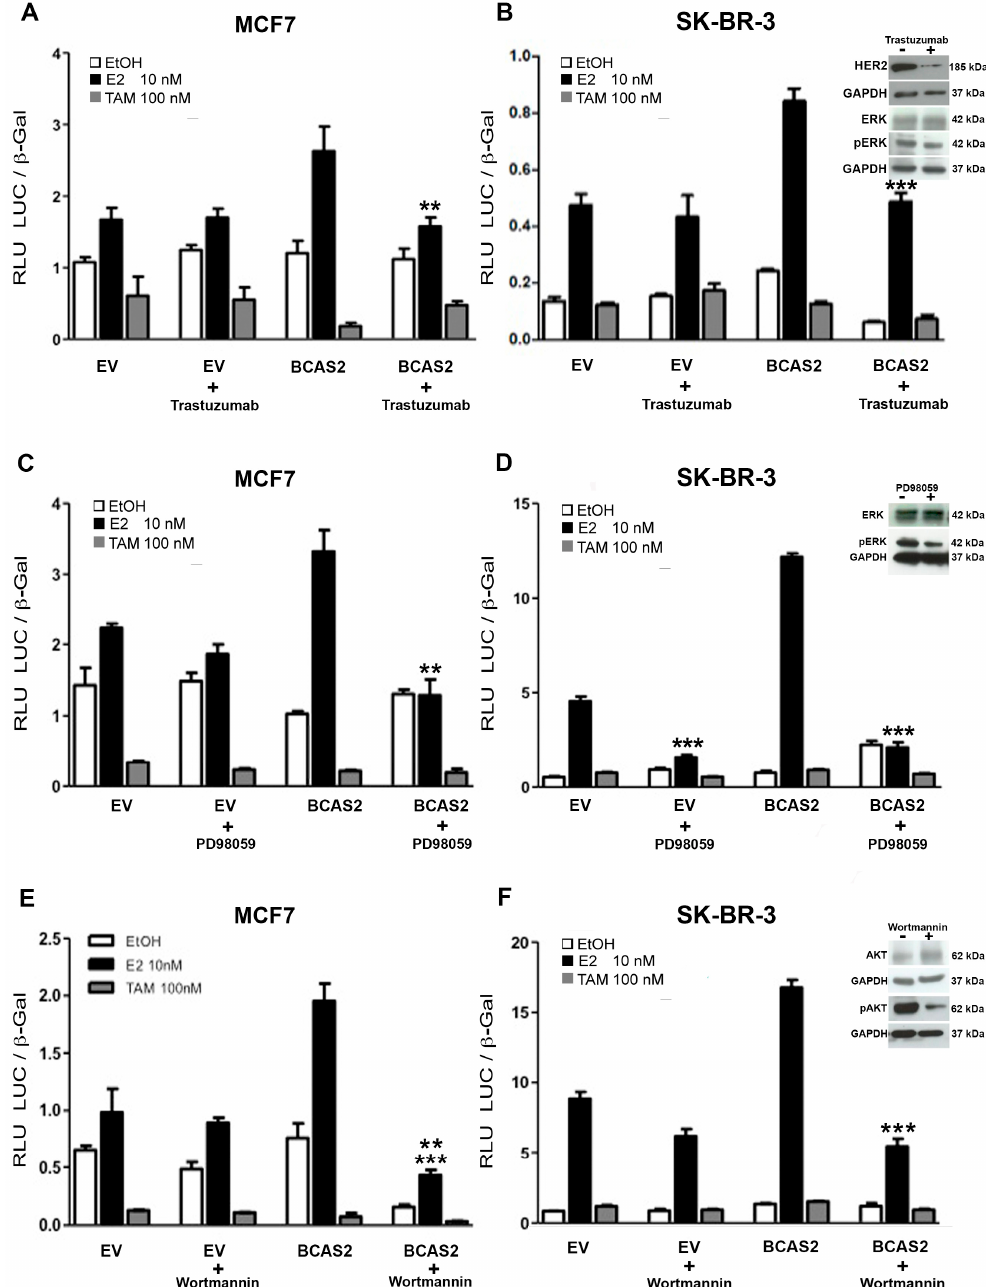
Figure 7 . Signal transduction pathways involved in BCAS2 activation. ( A , C and E ) MCF7 cells were transiently transfected with an ERE-luciferase reporter vector (200 ng) and BCAS2 (100 ng) in the absence (EtOH) or presence of 10 nM E2 or 100 nM TAM along with 50 g of Trastuzumab or 10 mM of PD98059 or 100 nM of Wortmannin, as indicated, for 48h. Empty vector (EV) (100 ng) was used as negative control. ( B , D and F ) SK-BR-3 cells were transfected and treated in the same manner as MCF7 cells, except that 50 ng of pSG-ER α were also transfected. Relative luciferase activity (RLU LUC/ β -gal) is shown as the mean ± SE of a representative assay carried out in triplicate, at least three times. Representative western blots show HER2 after 48 h of Trastuzumab treatment, ERK and ERK phosphorylation (pERK) after 48 h of Trastuzumab or PD98059 treatment, AKT and AKT phosphorylation (pAKT) after 48 h of Wortmannin treatment, each performed in triplicate or duplicate (Figure S2). GAPDH is used as control for protein loading. Statistical analysis was carried out using Student’s t -test; ** p < 0.005, *** p <